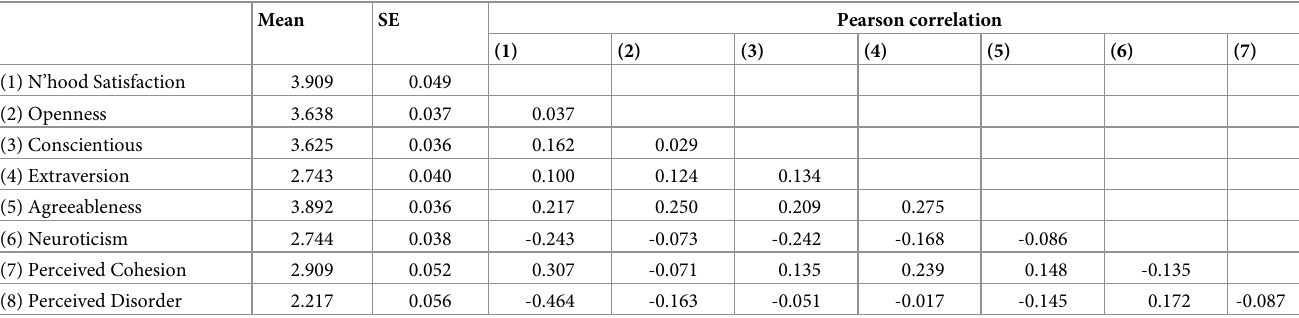
Table 2. Population estimates.